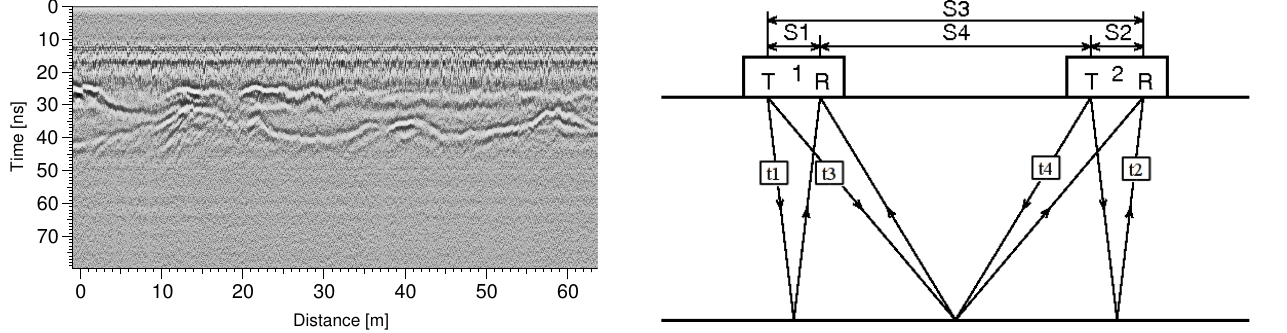
Fig. 1. Features of soil layering in the GPR radargram (p26 in Fig. 3).